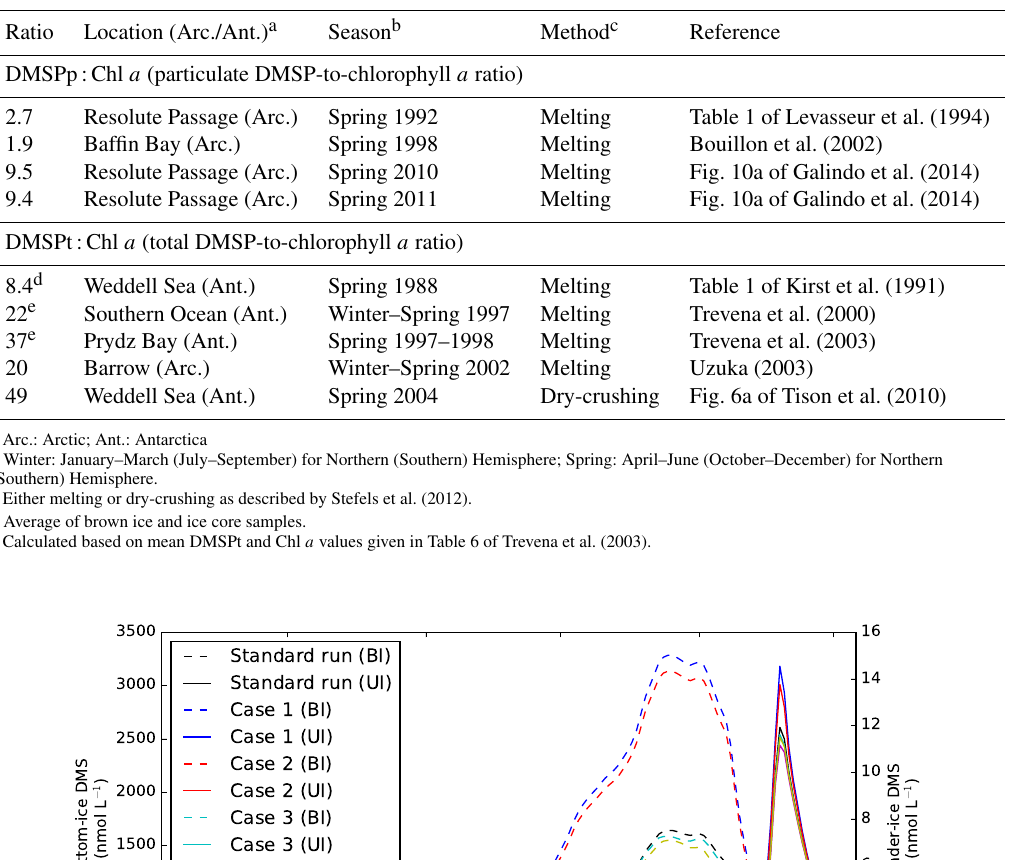
Table 3. Reported mean DMSPp:Chl a and DMSPt:Chl a ratios for diatom-dominated sea-ice samples. Ratio Location (Arc./Ant.) a Season b